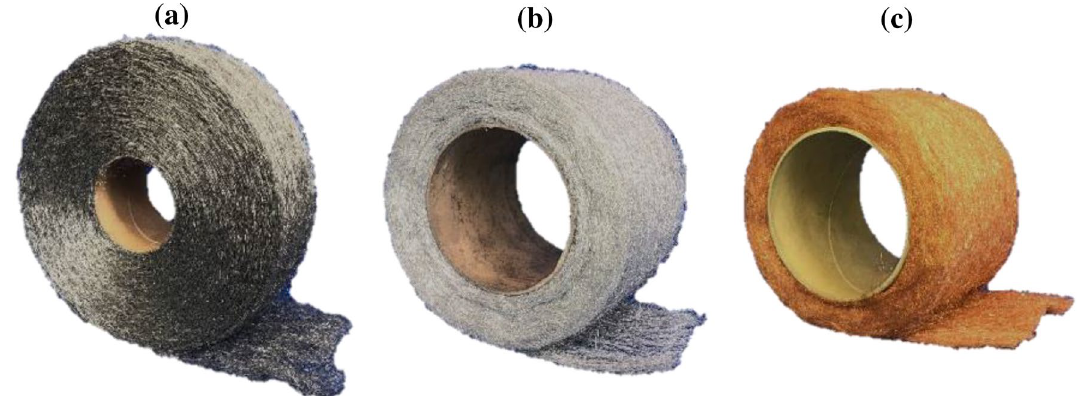
Fig. 1 Metal staple fibre reels: 1.4113 (a), AlMg5 (b) and Cu99